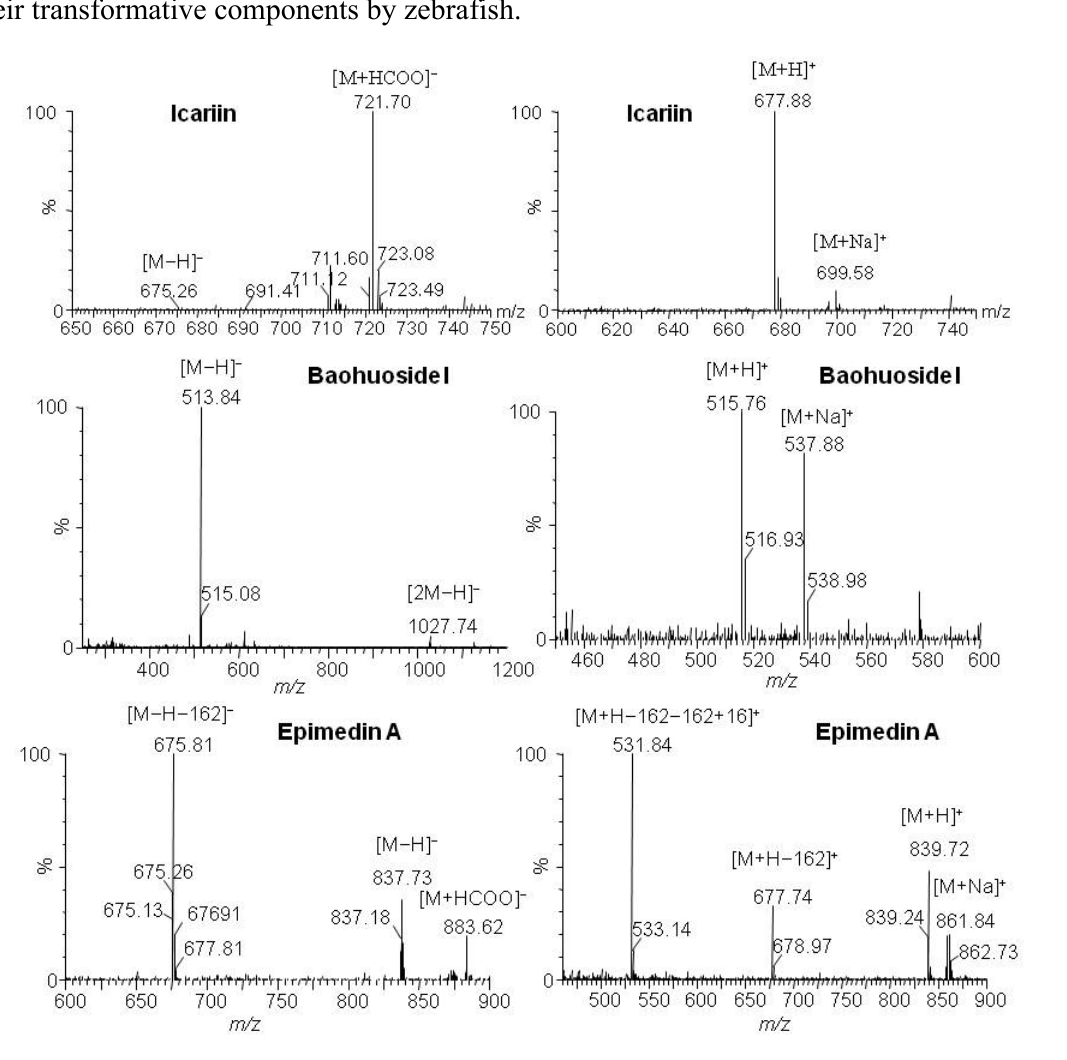
Figure 6. Representative MS spectra of icariin, baohuoside I, epimedin A, epimedin C and their transformative components by